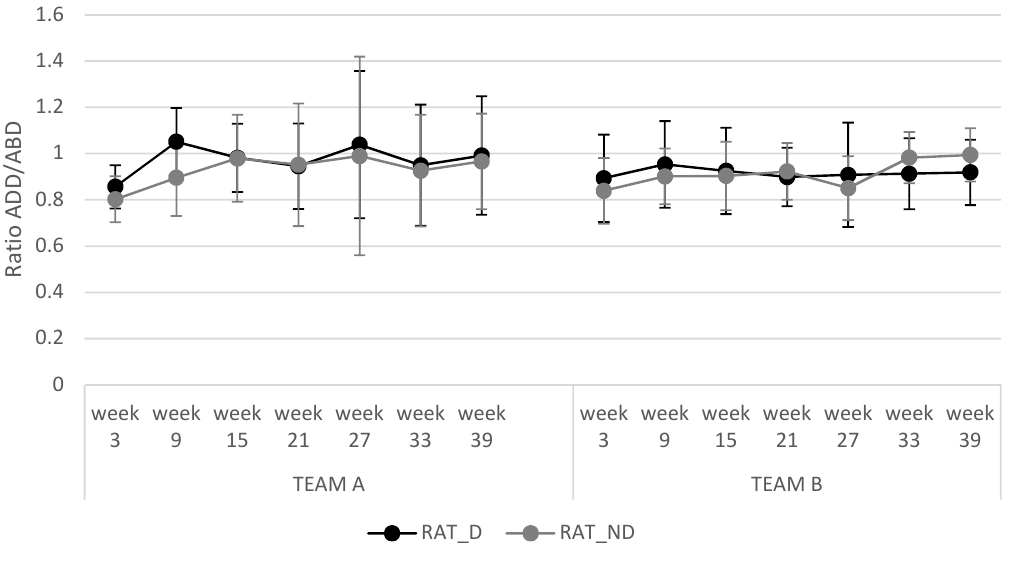
Figure 5. Evolution of adductor/abductor ratio during the season. RAT_D: adductor/abductor ratio dominant leg; RAT_ND: adductor/abductor ratio dominant leg.